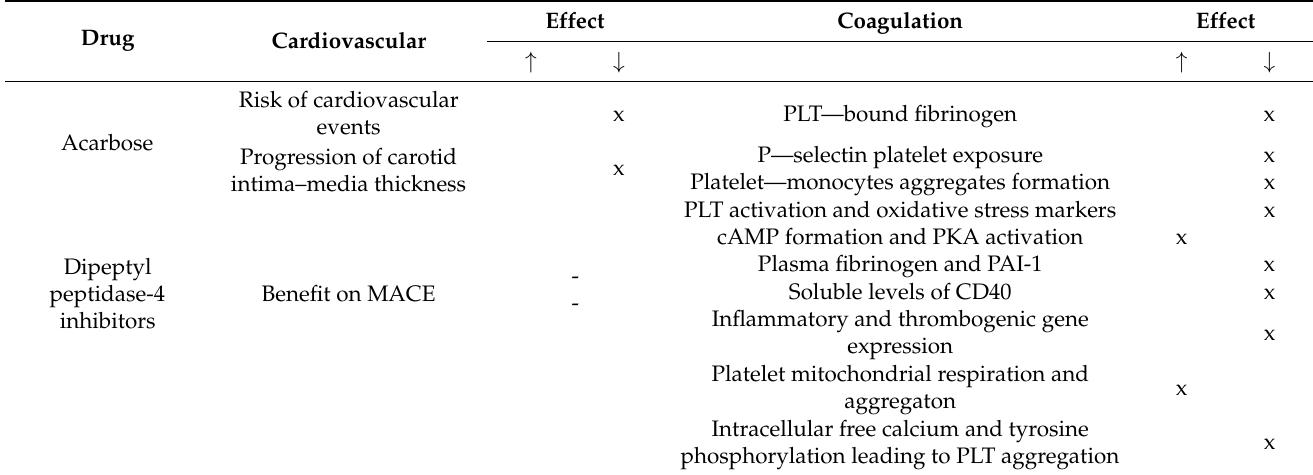
Table 2. Pleiotrophic effect of hypogycemic drugs on the cardiovascular and coagulation